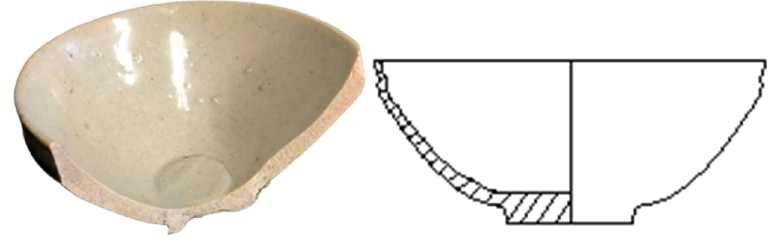
Figure 2. Structural anatomy of ceramics unearthed from Xiaopi kiln ceramics.